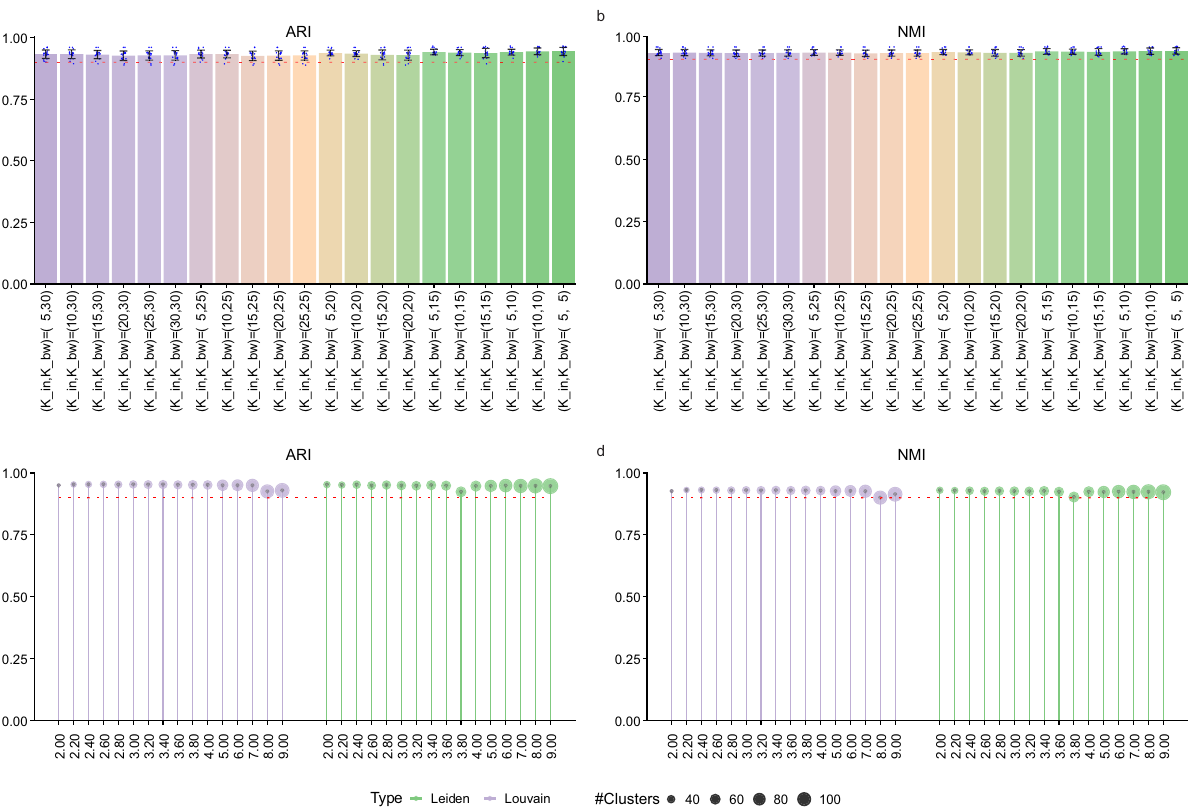
Fig. 8 | Robustness ofscDML to varying hyper parameters. The ARI ( a ) and NMI ( b )forscDMLwiththreedifferentresolutionsforLouvainalgorithm(3.0,6.0,9.0), twodifferentnumbersofhighlyvariablegenes(1000and2000),threenumbersof clustersaftermerging(11,12and13),and21differentcombinationsfor(K_bw,K_in). Each bar represents a combination of (K_bw, K_in). There are 18 cases with respect toeachbar,wherethebarheightisthemeanvalueandtheerrorbaristhestandard